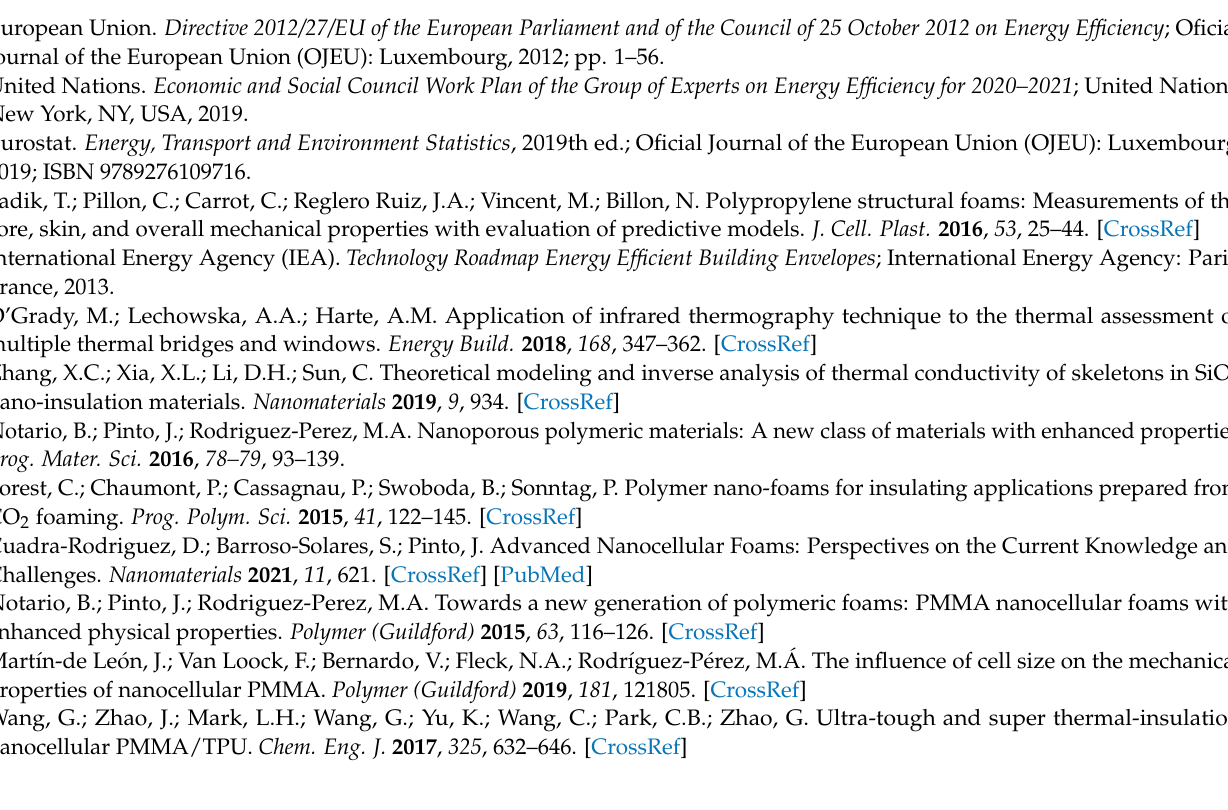
80 ◦ C, Figure S8. Cell size histograms corresponding to the samples included in Table 1: PMMA bulk samples foamed at 20 MPa and 40 (a), 50 (b), or 60 (c) ◦ C, 30 MPa and 40 (d), 50 (e), or 60 (f) ◦ C; PMMA film samples foamed at 20 MPa and 50 (g), or 60 (h) ◦ C, 30 MPa and 40 (i), 50 (j), or 60 (k) ◦ C; 25/75 PMMA/MAM bulk samples foamed at 20 MPa and 40 (l), 50 (m), or 60 () ◦ C, 30 MPa and 40 (o), 50 (p), or 60 (q) ◦ C; 25/75 PMMA/MAM film samples foamed at 20 MPa and 40 (r), 50 (s), or 60 (t) ◦ C, 30 MPa and 40 (u), 50 (v), or 60 (w) ◦ C, Figure S9. Cell size histograms corresponding to the samples included in Table 2 (with the exception of samples also included in Table 1 and Figure S8): PMMA bulk samples post-foamed for 1 min at 40 (a), 60 (b), or 80 (c) ◦ C; PMMA film samples post-foamed for 1 min at 40 (d), 60 (e), or 80 (f) ◦ C; 25/75 PMMA/MAM bulk samples post-foamed for 1 min at 40 (g), 60 (h), or 80 (i) ◦ C; 25/75 PMMA/MAM film samples post-foamed for 1 min at 40 (j), 60 (k), or 80 (l) ◦ C, Figure S10. Scheme of the evolution of the nanostructures of 90/10 PMMA/MAM near-equilibrium (a) and out-of-equilibrium (b) blends during the foaming process: before (up), nucleation (middle), and stabilization